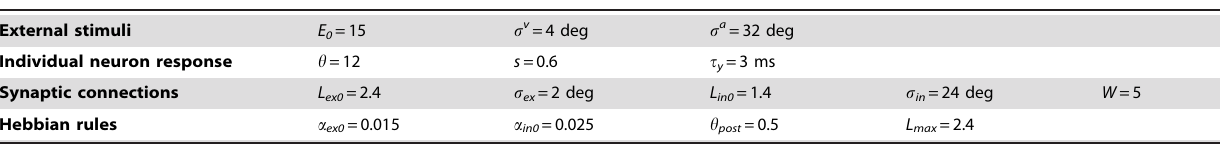
Table 1. Basal value of model